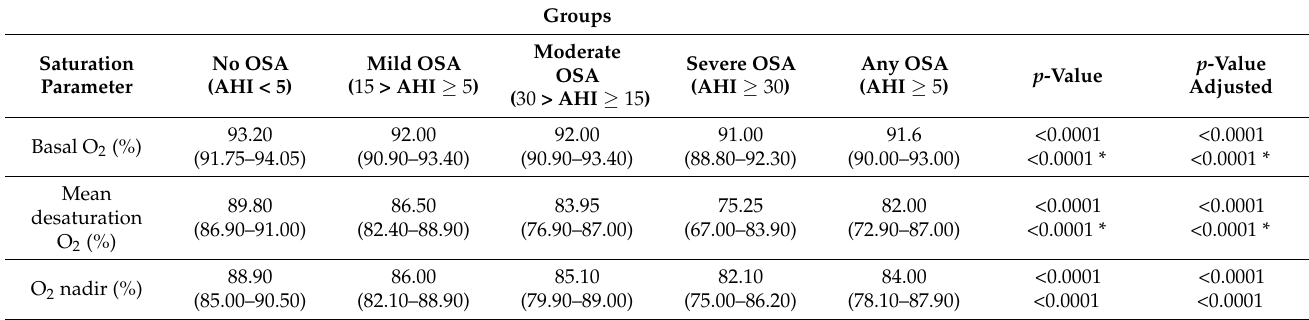
Table 2. Comparison of O 2 saturation parameters in different OSA severity